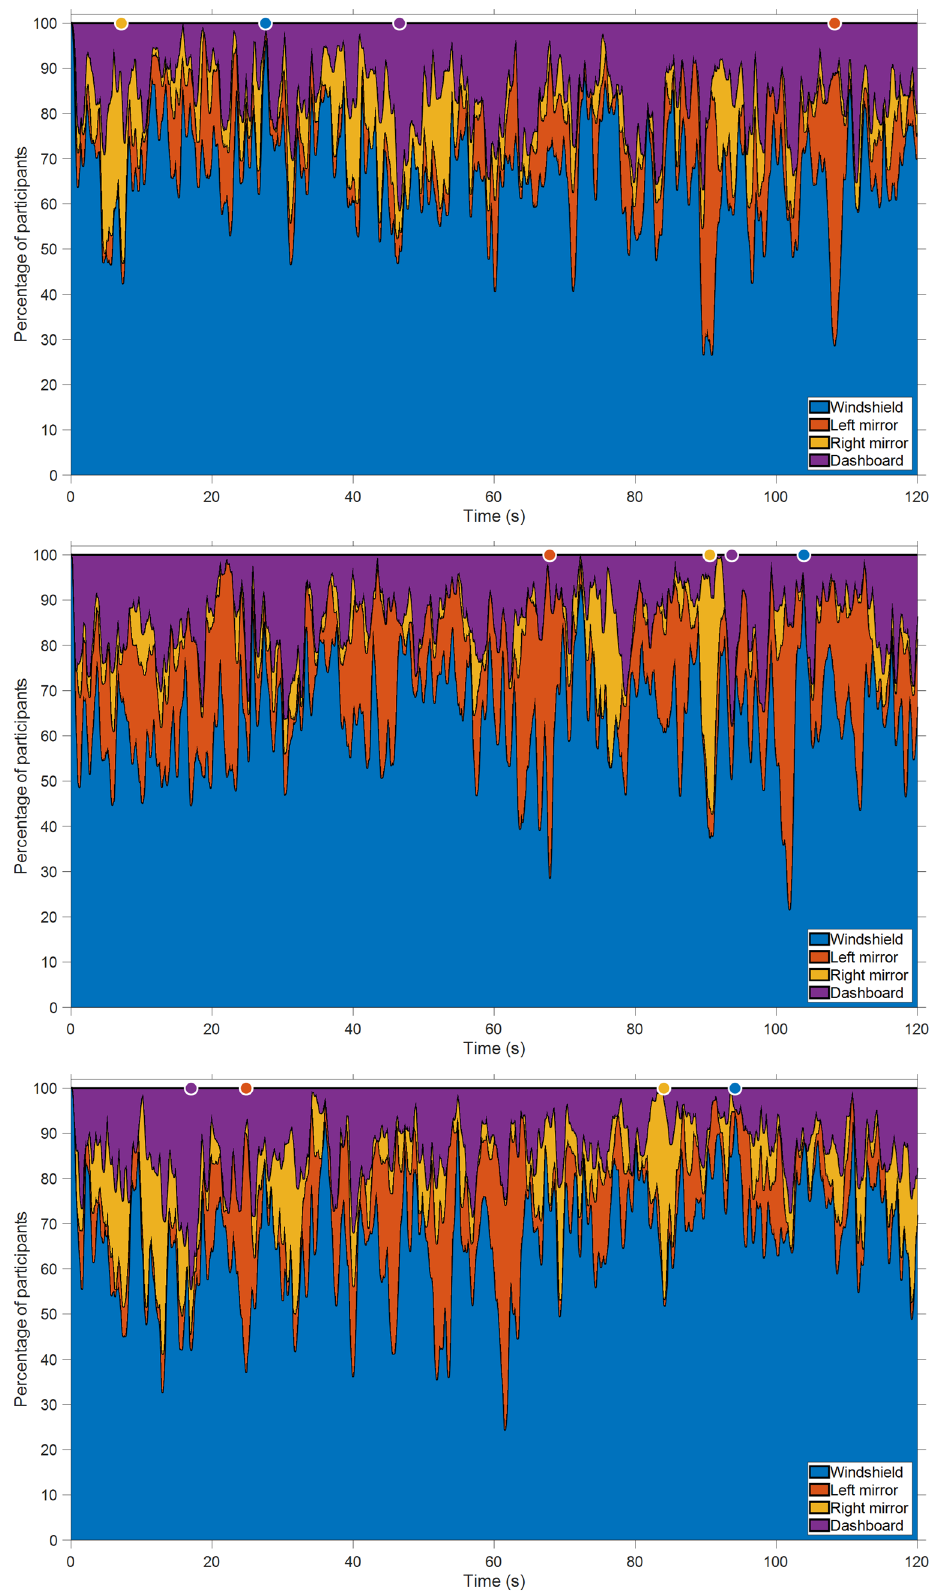
Figure 3 . Attention distribution across four areas of interest (AOIs) for Video 1 ( top ), Video 2 ( middle ), and Video 3 ( bottom ) in the Baseline task. The colored circular markers at the top of each figure represent the moments where the maximal number of participants glanced at the AOI.